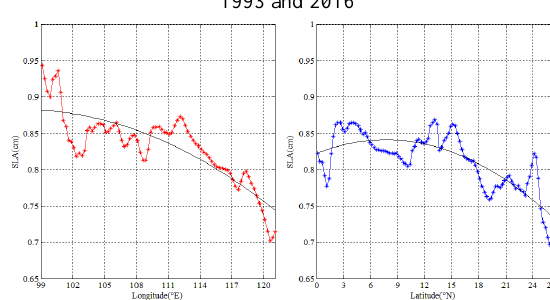
Figure 2. Variations of annual mean SLA between 1993 and 2016 with respective to longitude and latitude Before analyzing the sea level variability in the SCS, the correlation of SLA time series between satellite altimetry data and tide station observations was firstly compared, as shown in Figure 3. Through the correlation analysis of the two data sets, 71.43% of the stations’ correlation coefficient was above 0.80, 48.57% was up to 0.90 above. In the north of SCS, between 15°N and 26°N, the two SLA time series in five of seven stations were positively corrected with a higher correlation coefficient than 0.60. Only one